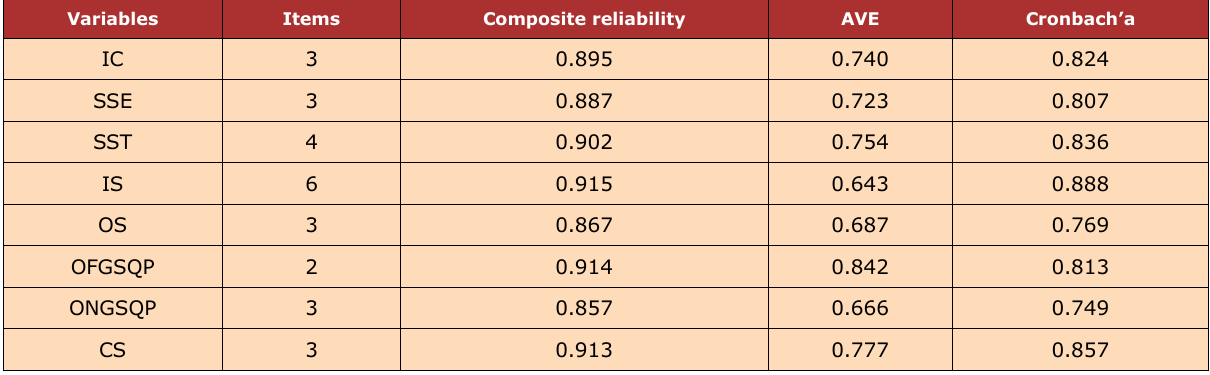
Table 3. Convergent validity analysis